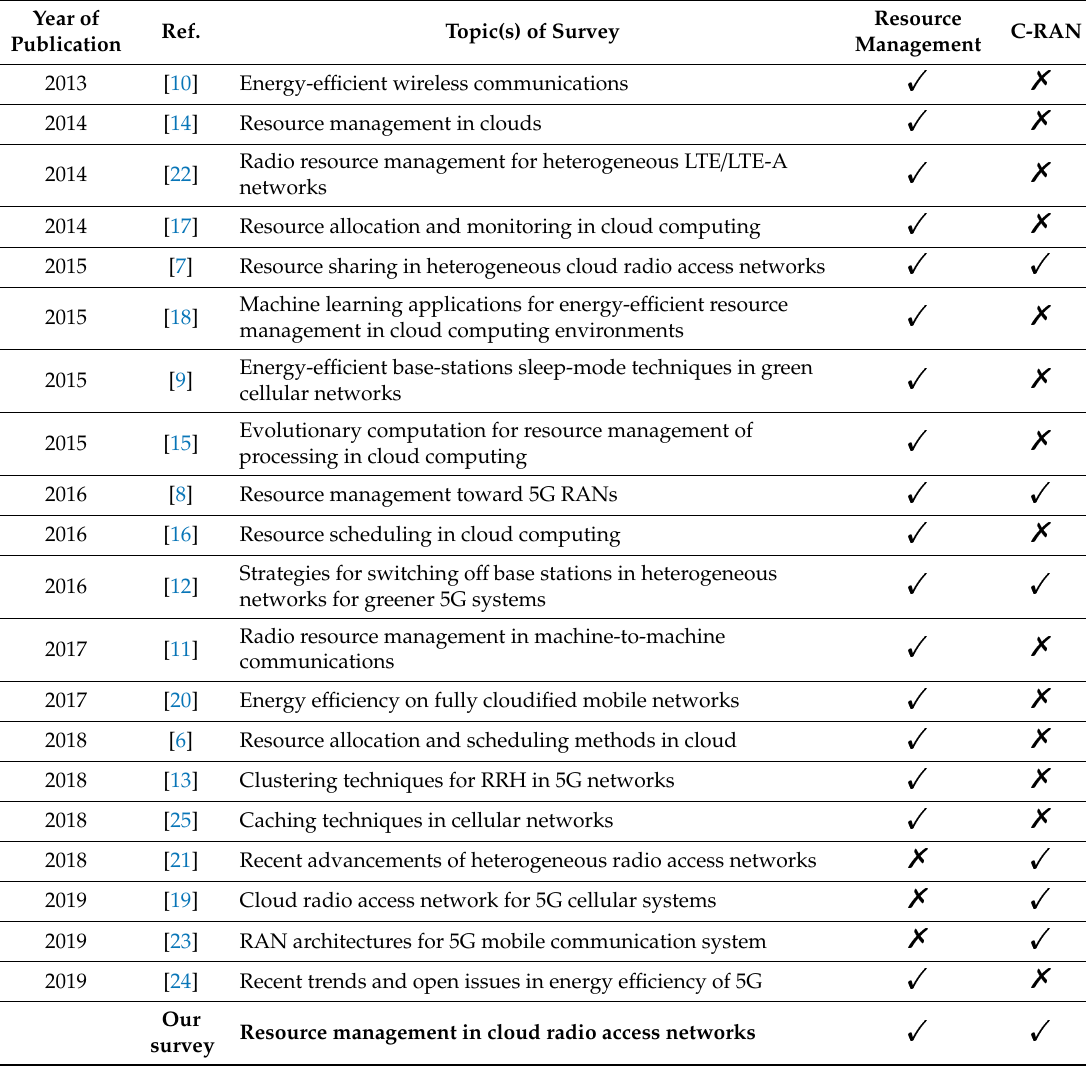
Table 1. Existing surveys on related